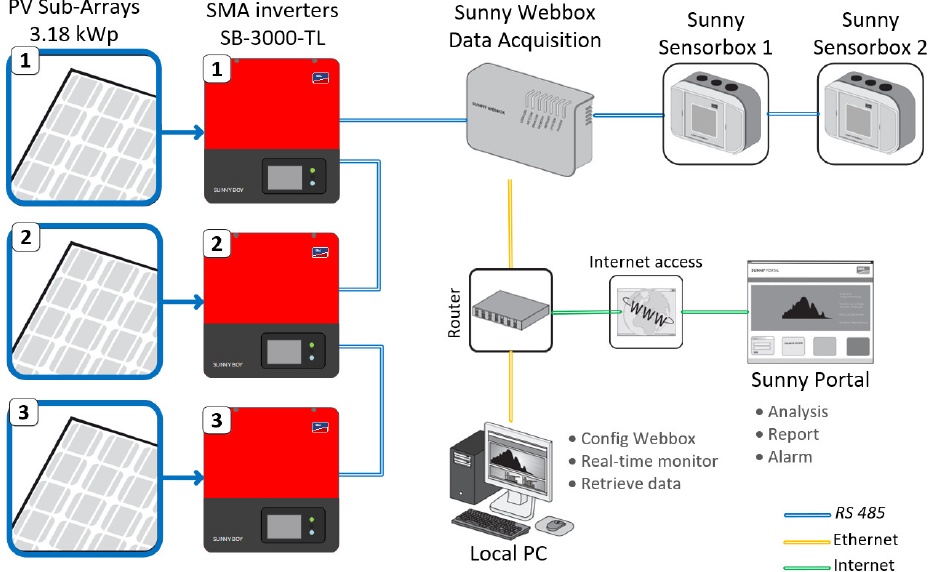
Figure 4. Synoptic scheme of the turnkey monitoring system provided by SMA manufacturer.